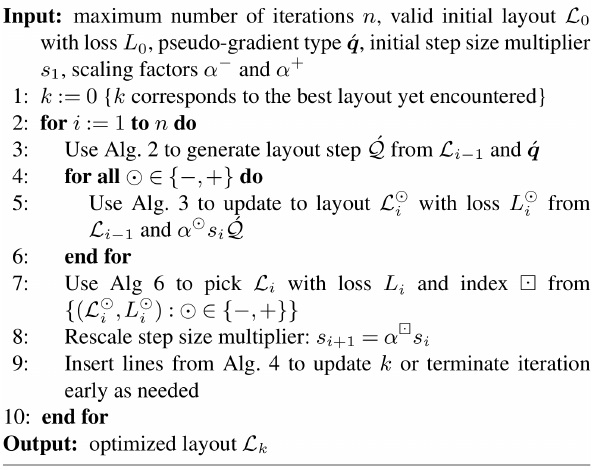
Algorithm 5 modifies Algorithm 1 by adding an